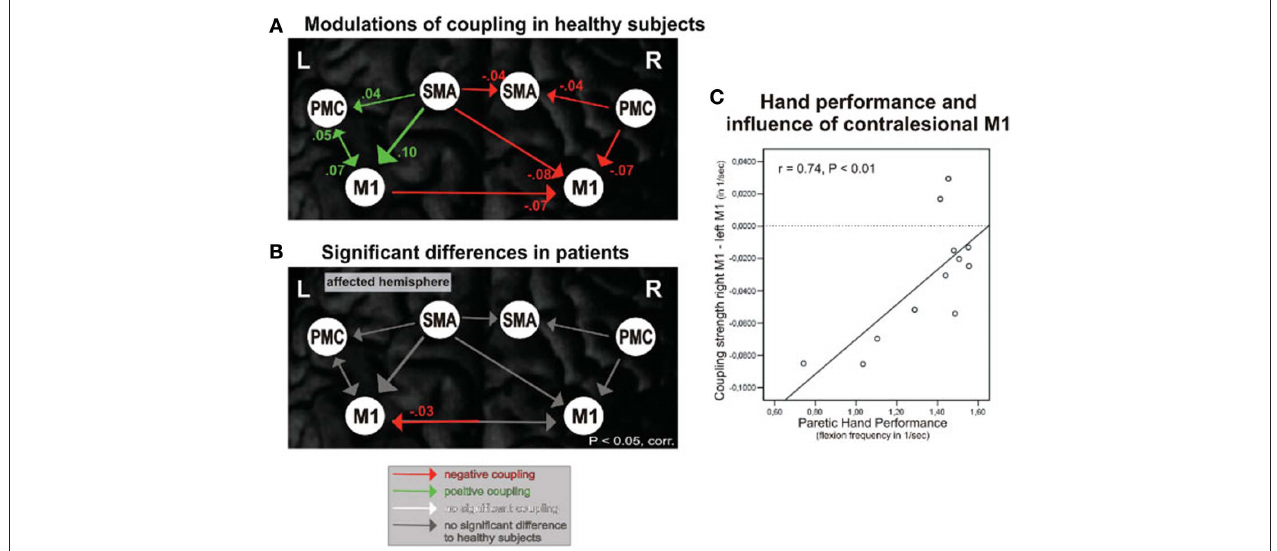
Figure 1 | effective connectivity of motor network during unimanual hand movements. (A) Functional coupling in healthy control subjects during right hand movement. (B) Significant differences in functional coupling during affected (right) hand movement between healthy control subjects and subjects